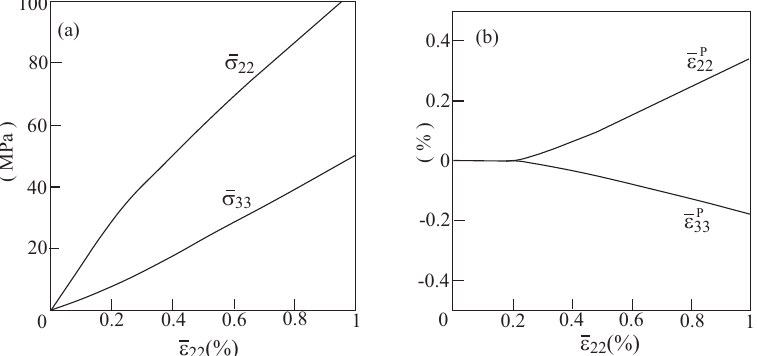
Figure 11. The elastoplastic response of aluminum and elastic material in the re-entrant array with θ = 75 ◦ that generates a positive effective elastic Poisson’s ratio. ( a ) Average transverse stresses and ( b ) transverse plastic strains.